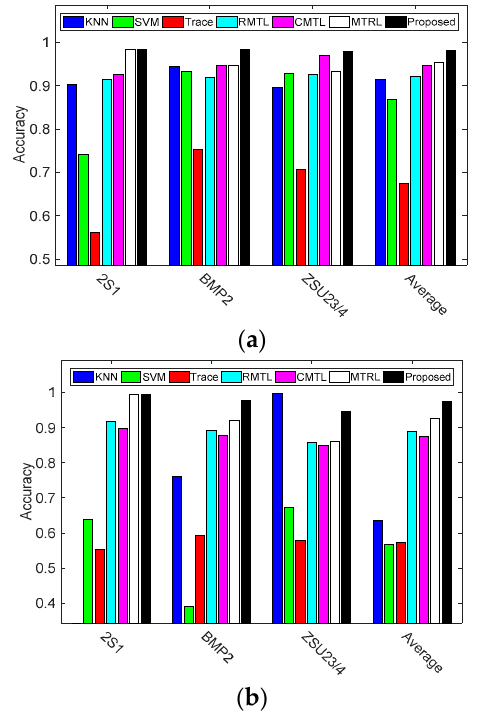
Figure 13. Recognition rates of three vehicles under EOC. ( a ) Testing under 30° depression; ( b ) Testing under 45° depression. Table 7. Recognition rates of all the compared methods under EOC.